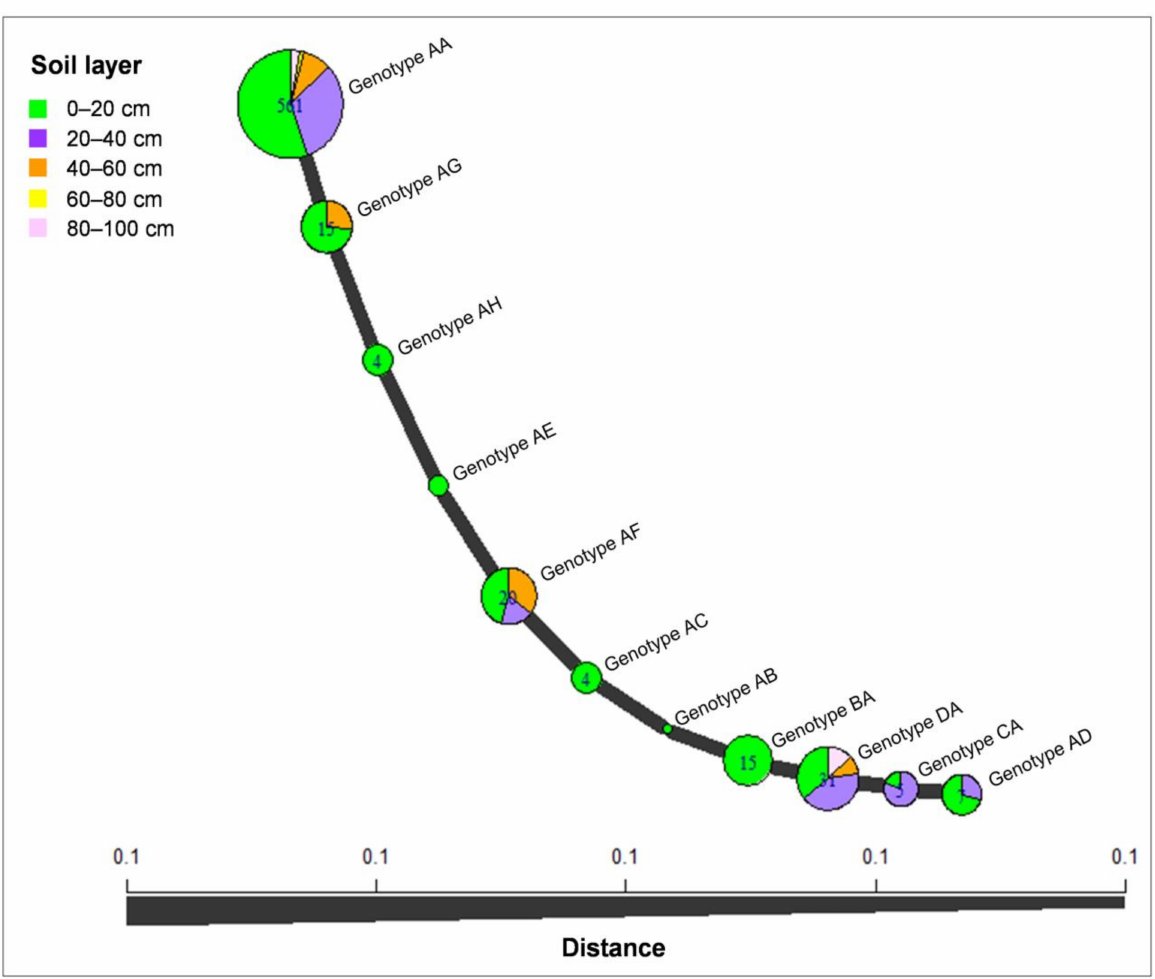
Figure 7. Minimum spanning network constructed using Bruvo’s distances showing that the C. hongkongensis isolates were grouped into 11 genotypes based on tef1 and tub2 sequences. The size of a node is proportional to the number of represented tef1 - tub2